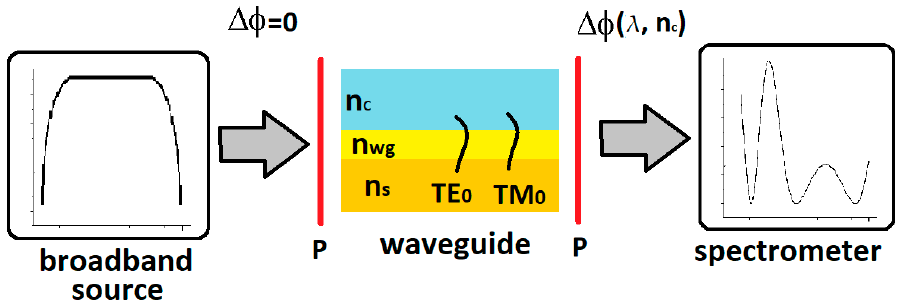
Figure 1. Schematic diagram of a broadband di ff erence interferometer. The system includes a broadband light source, polarizer (P), waveguide ( n s : substrate, n wg : waveguide layer, n c : cover), and a spectrometer for recording the output